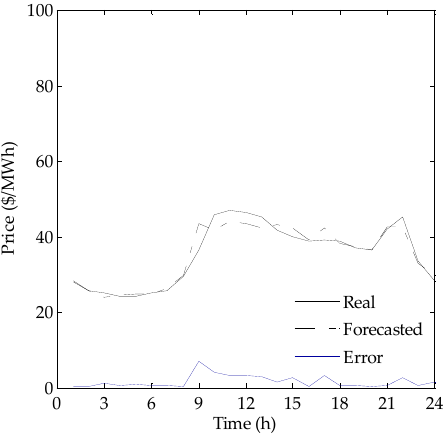
Figure 10. May, 13th 2006 results for the PJM (Pennsylvania ‐ New Jersey ‐ Mary) land market.